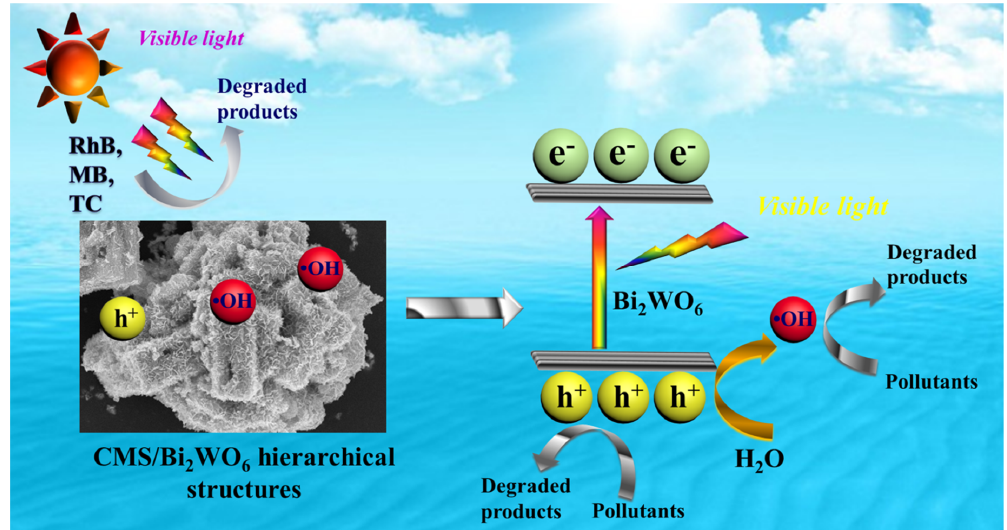
Figure 10. Proposed photocatalytic mechanism of the CMS/BWO composite photocatalyst.